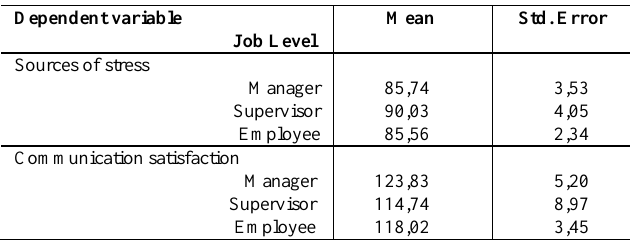
Table 3. Estimated marginal means across job levels Dependent